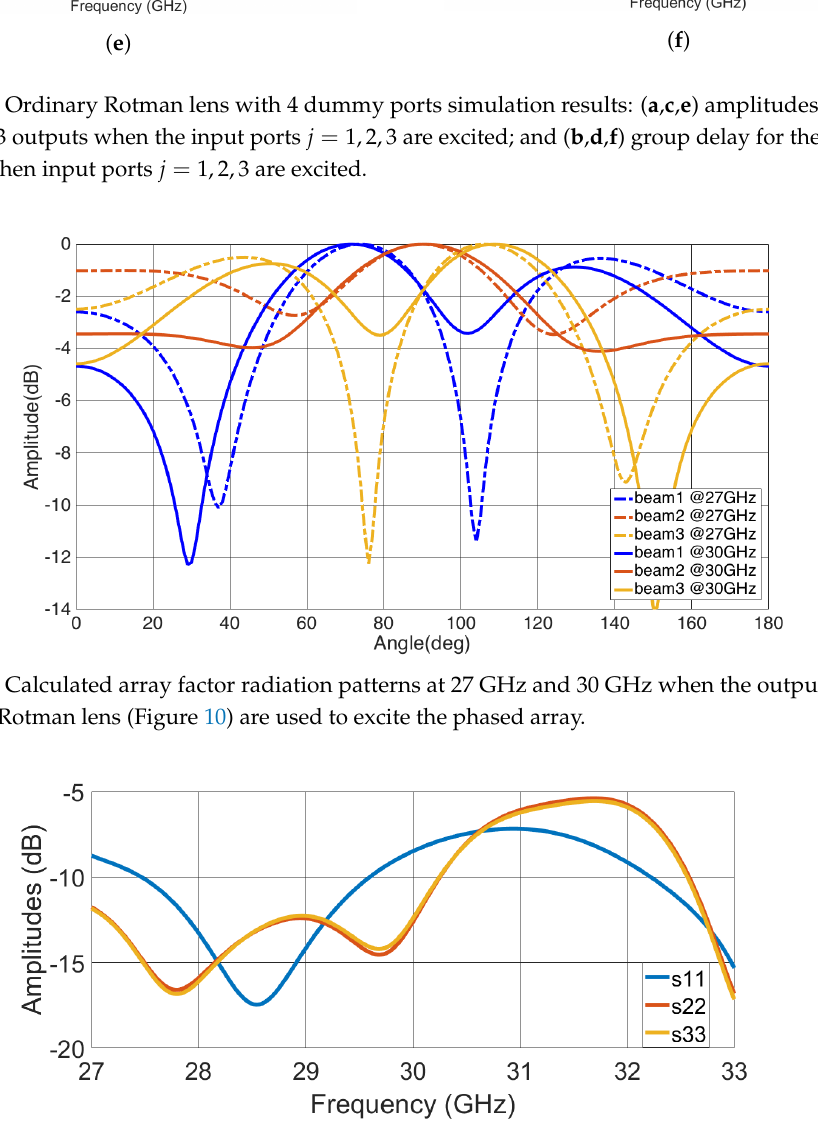
Figure 23. Ordinary Rotman lens with 4 dummy ports reflection